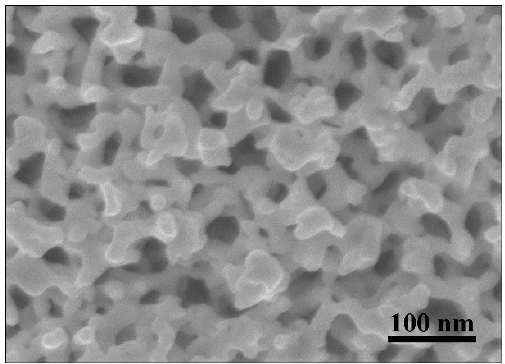
Figure 1. SEM micrograph of NP